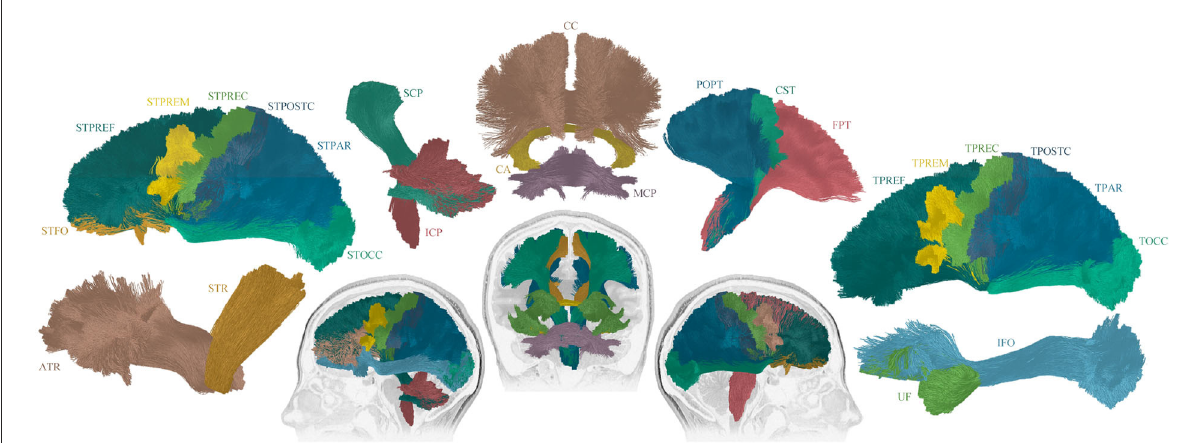
FIGURE1 Overview of the 25 reconstructed tracts of interest. The following tracts were included (tracts names were assigned following (26): Thalamo - Prefrontal (TPREF), Premotor (TPREM), Precentral (TPREC), Postcentral (TPOSTC), Parietal (TPAR), and Occipital (TOCC); Striato - Fronto-Orbital (STFO), Prefrontal (STPREF), Premotor (STPREM), Precentral (STPREC), Postcentral (STPOSTC), Parietal (STPAR), and Occipital (STOCC); Anterior thalamic radiation (ATR), Superior thalamic radiation (STR), Corticospinal (CST), Fronto pontine (FPT), Parieto-occipital pontine (POPT), Inferior cerebellar peduncle (ICP), Middle cerebellar peduncle (MCP), Superior cerebellar peduncle (SCP), Inferior fronto-occipital fascicle (IFO), Uncinate fascicle (UF), Commissure anterior (CA), and Corpus callosum (CC). For tracts that exist in both hemispheres, the right and left sides were included in the image construction, though only the sagittal view is displayed. The tracts that cross between the hemispheres are displayed in coronal view.